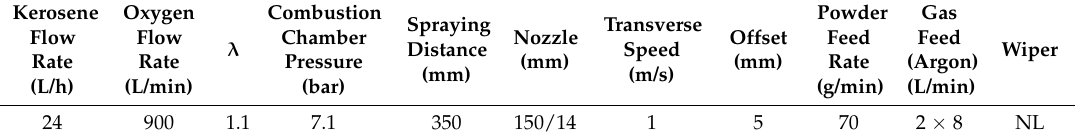
Table 1. The parameters of the HVOF thermal-spraying process with a GTV-K2 system.